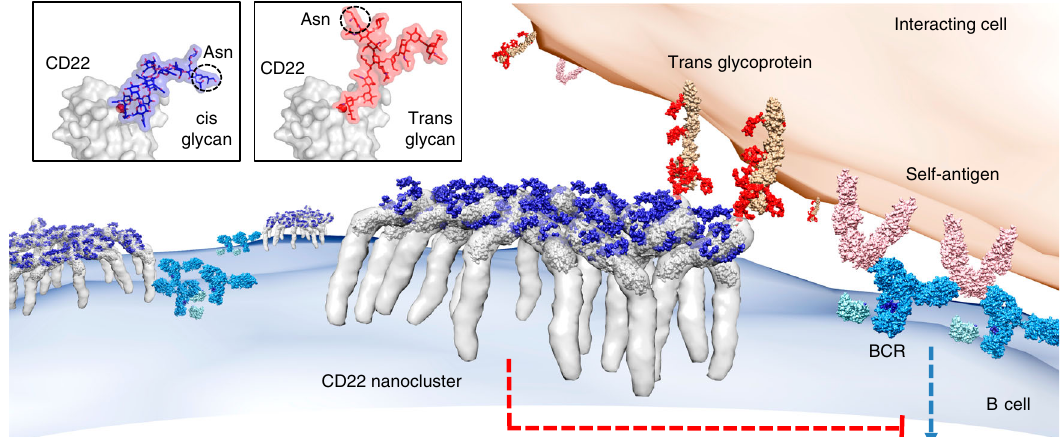
Fig. 6 Model depicting the ability of the elongated, tilted CD22 structure to form nanoclusters on the surface of B cells. Binding to Sia-terminated glycans in cis ( blue surface ) and trans ( red surface ) is proposed to be mediated by the fl exibility of branched complex glycans ( inset ) and the local micro-environment. The CD22 ECD EM envelope is shown as gray surface , fi tted with the crystal structure of CD22 20 – 330,5A . N-linked glycans modeled at all CD22 20 – 330,5A - predicted sites are shown as blue surfaces . BCRs ( sky blue and cyan ) (PDB IDs: 1HZH and 3KH0) 68, 69 are shown binding to self-antigens ( pink ) (PDB ID:4ZXB) 70 on an interacting cell ( salmon surface ). Blue arrow represents BCR activation, whereas red dashed line represents CD22-mediated BCR inhibition. Engagement of CD22 with trans glycans ( red ) promotes recruitment of CD22 nanoclusters to the immune synapse resulting in B-cell